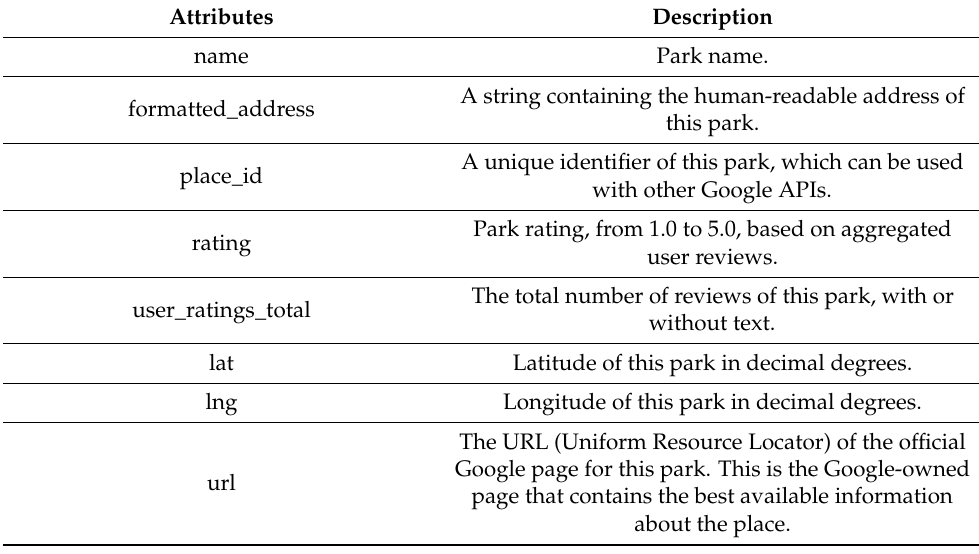
Table 1. Park information collected through the Google Maps API.